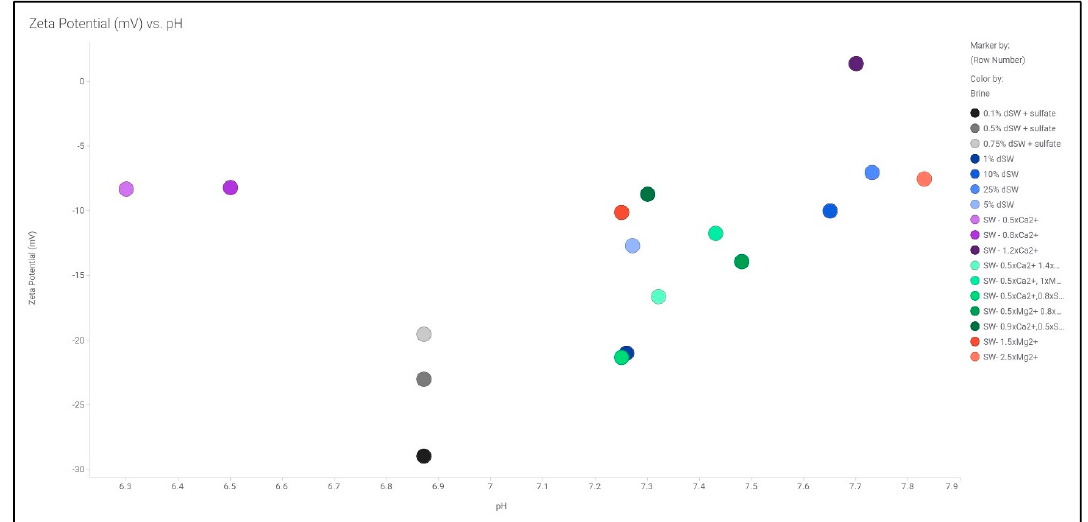
Figure 3. Zeta potential of various brines as a function of pH measurement of each brine.